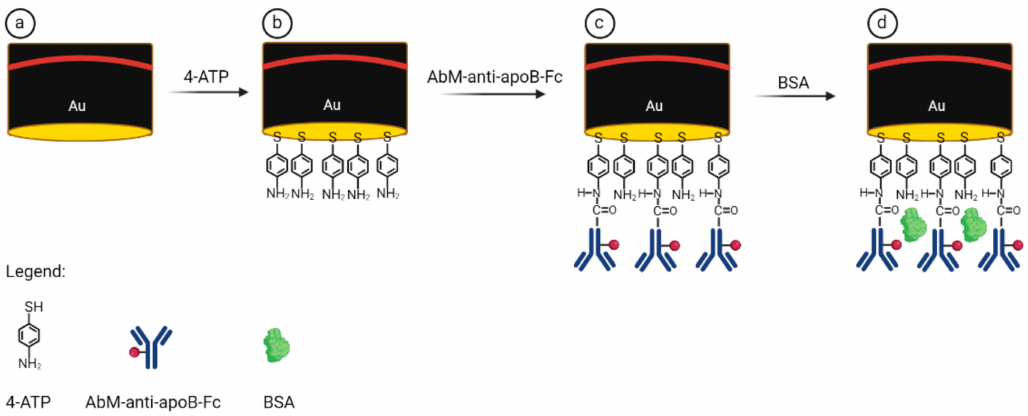
Scheme 2. Schematic representation of the electrochemical immunosensor preparation steps: ( a ) bare Au, ( b ) Au/4-ATP, ( c ) Au/4-ATP/AbM-anti-apoB-Fc, ( d ) Au/4ATP/AbM-anti-apoB-Fc/BSA.